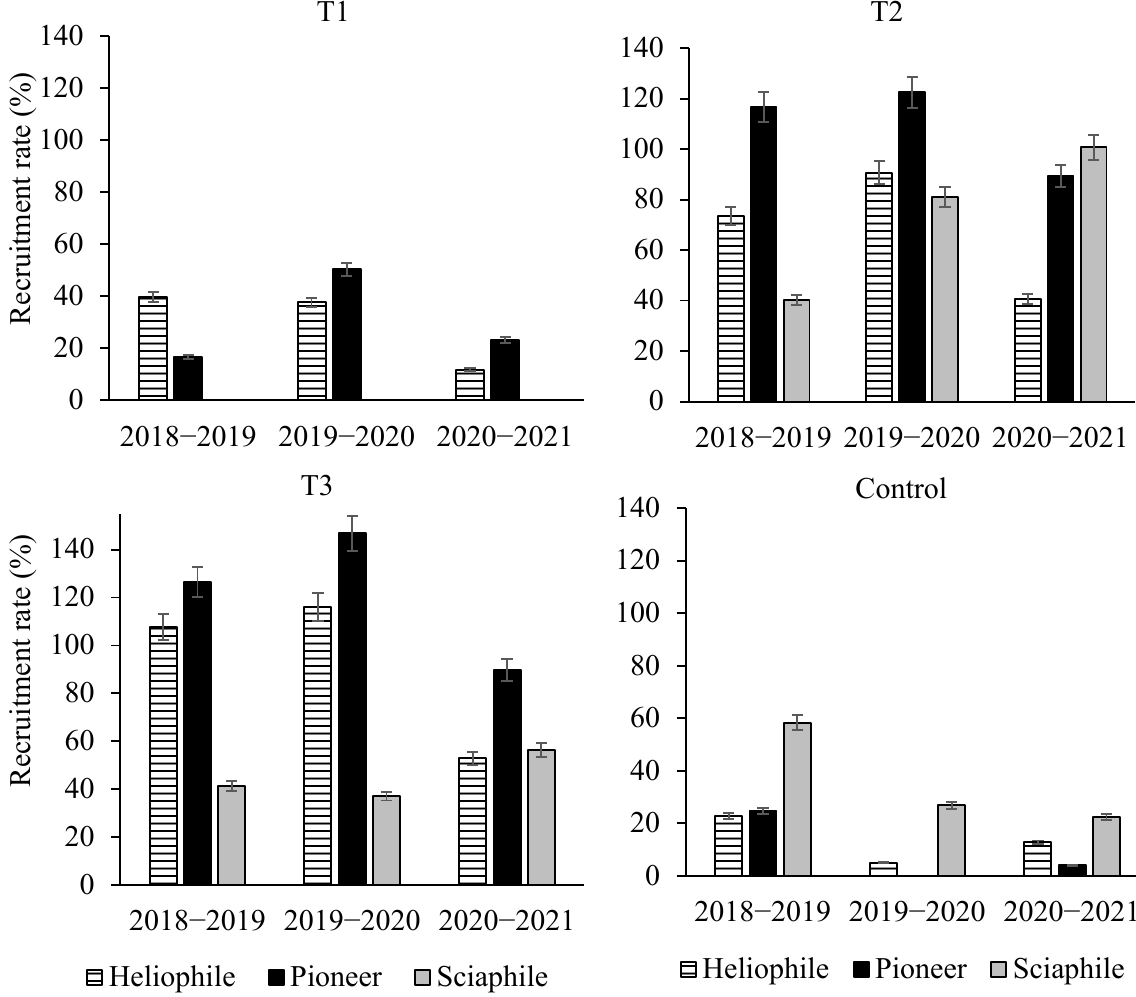
Figure 5. Tree recruitment rate by treatment. T1 = cocoa plantations which were regularly maintained and exploited, T2 = cocoa plantations which were not maintained but exploited, T3 = cocoa plantations without activities, and Control = a forest